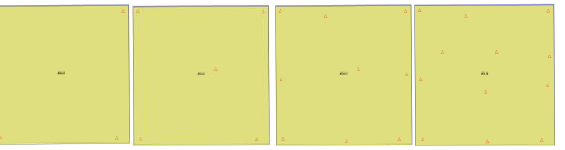
Figure 3. Control point layout schemes